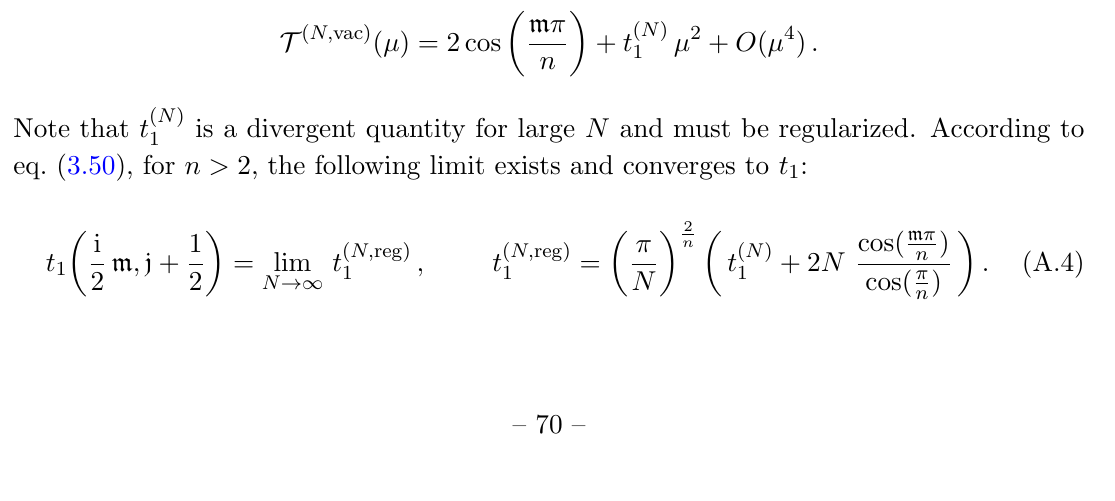
Figure 9 . On the left panel, a plot of (cid:28) (vac) for n = 3, 2 j = m = 1 compared to its large (+ (cid:21) 2 ) asymptotic following from eq. (2.53). On the right panel, ~ (cid:28) (vac) = (cid:28) (vac) exp and compared with the large ( (cid:0) (cid:21) 2 ) asymptotic derived from eqs. (2.43), (2.44). The scaling function was numerically estimated by interpolating to N = 1 the data for N = 500 ; 1000 ; 2000 ;